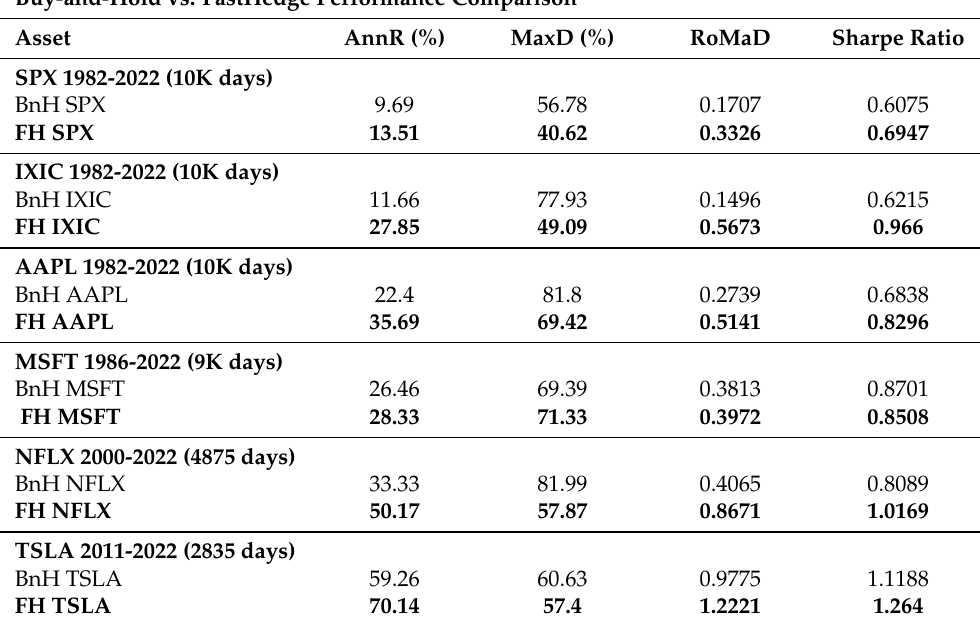
Table 2. Summary of key results of this paper in tabular form. A trading suite called FastHedge was developed, encompassing a large number of rule-based algorithms, which shows versatility in application to indices, as well as individual stocks, to provide strong performance, as well as reduced drawdowns, significantly reducing the effect of Black Swan events, a key design goal of the project. FastHedge models are generally leveraged. The simulations in the table end on 22 April 2022. Buy-and-Hold vs. FastHedge Performance